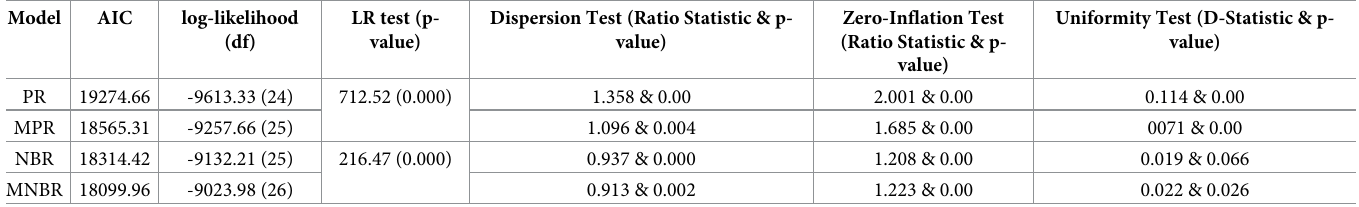
Table 2. Akaike’s information criteria (AIC), log-likelihood, likelihood-ratio (LR), dispersion, zero-inflation and uniformity tests (based on Kolmogorov’s D-statis- tic) for the one-part Poisson regression (PR), negative-binomial regression (NBR), mixed PR (MPR) and Mixed NBR (MNBR) models.